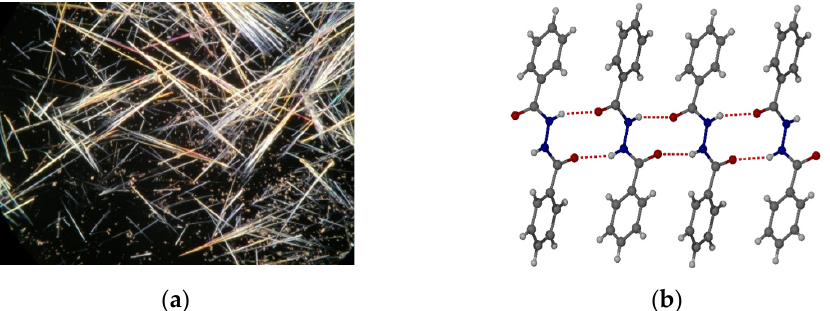
Figure 2. ( a ) Crystals of G1 from ethylene glycol. ( b ) Crystal packing in G1 showing hydrogen- bonded interactions between N-H and C=O groups (N···O 2.92 Å) [18].